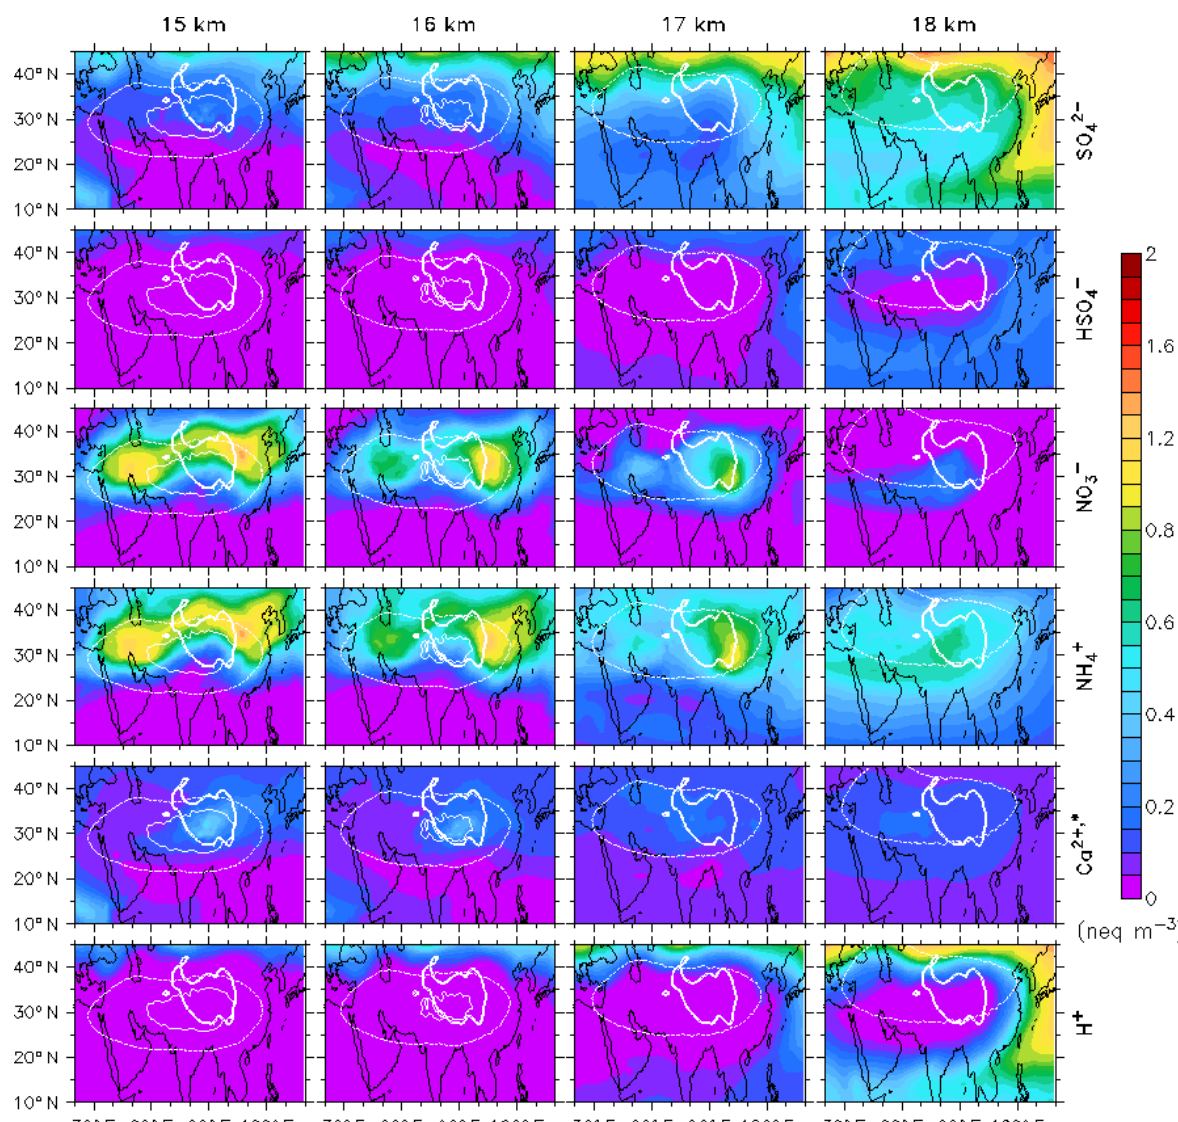
Figure 9. Same as Fig. 8 but for the year 2012 with a different color